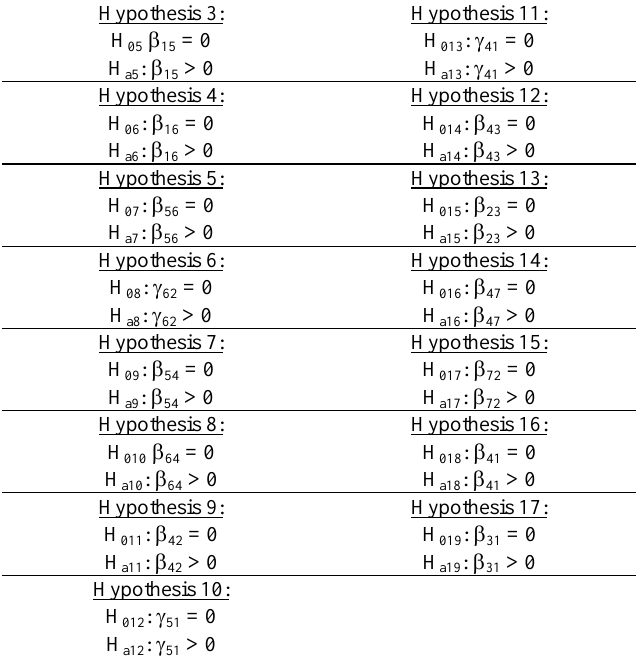
Table 1: Path coefficient statistical